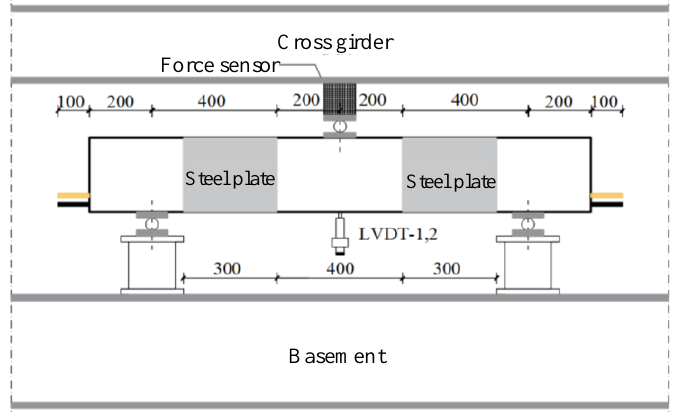
Figure 8. Setup of three-point bending test.